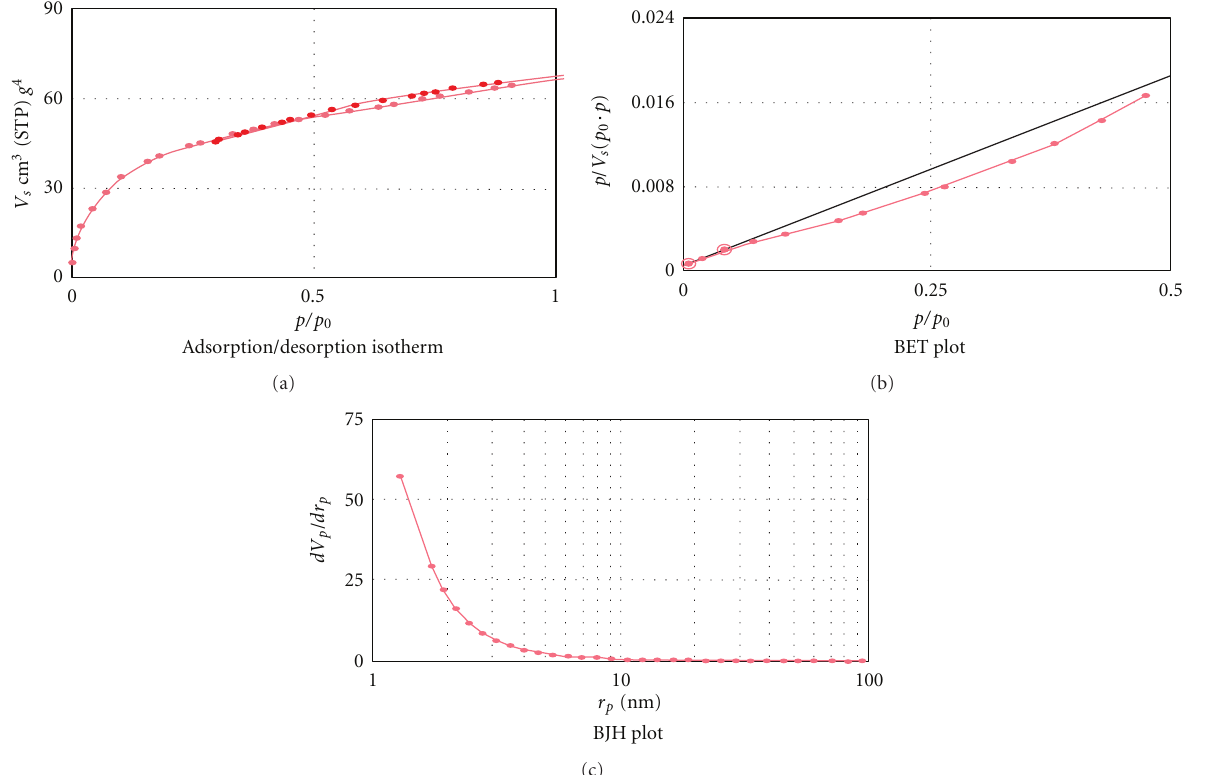
Figure 3: (a) TEM, which shows the image of Pd nanoparticle, (b) SEM of PNP-SBNPM (magnification of 500).